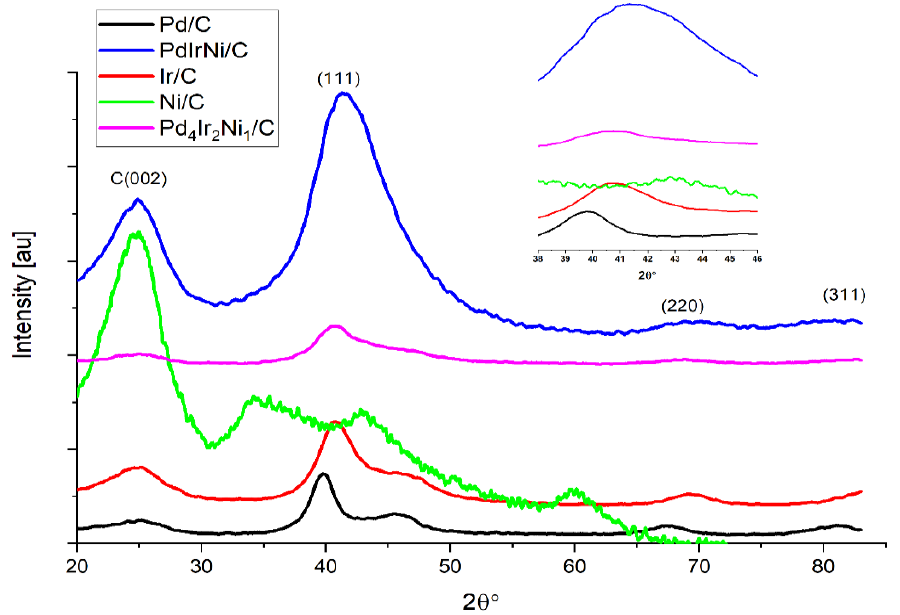
Figure 1. X-ray diffraction (XRD) patterns of Pd/C, Ir/C, Ni/C, Pd 4 Ir 2 Ni 1 /C and PdIrNi/C, inset figure: an enlarged (111) peak.